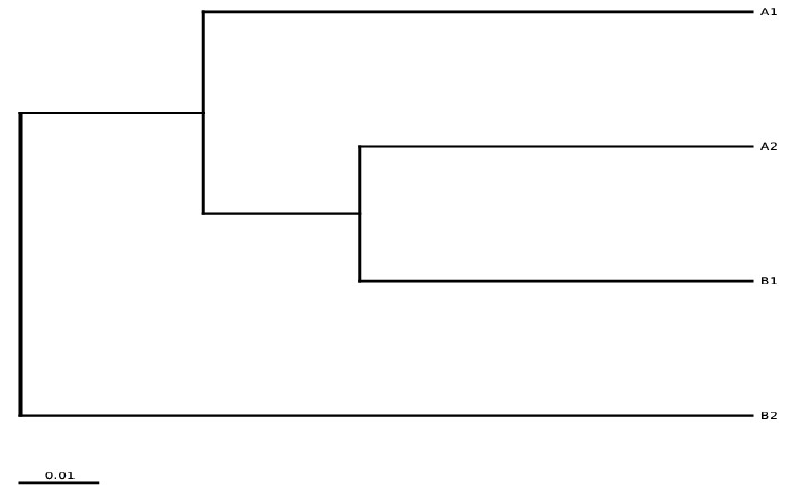
Figure 6. A taxonomic tree showing the bacteria isolation from soil samples.